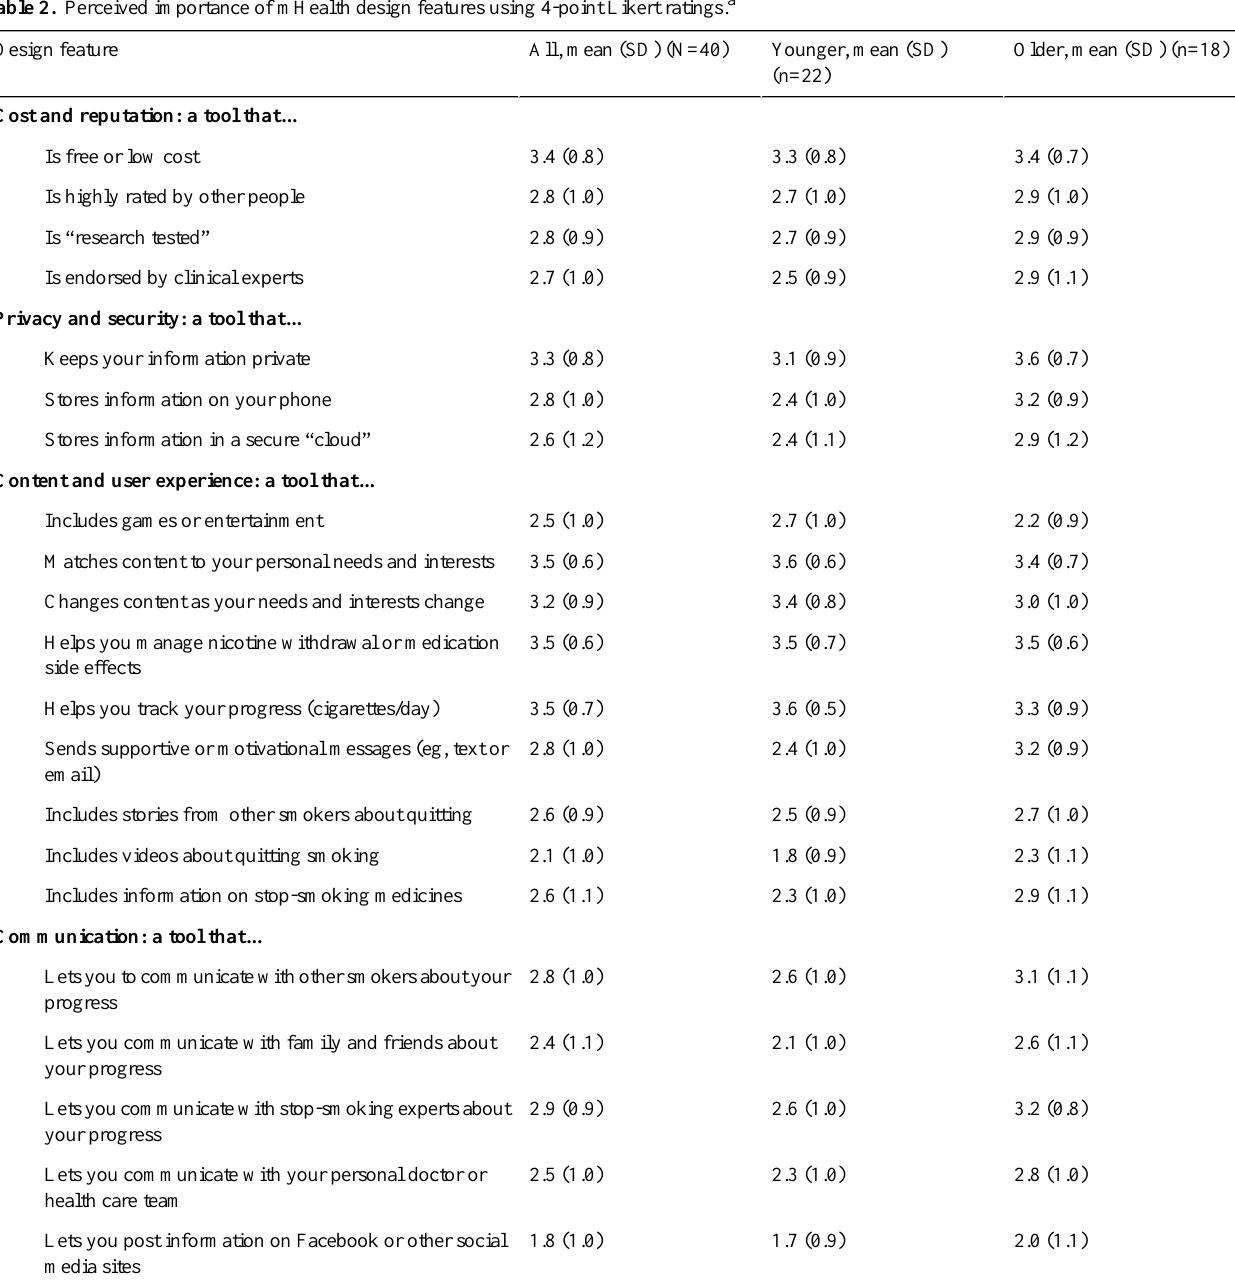
Table 2. Perceived importance of mHealth design features using 4-point Likert ratings. a